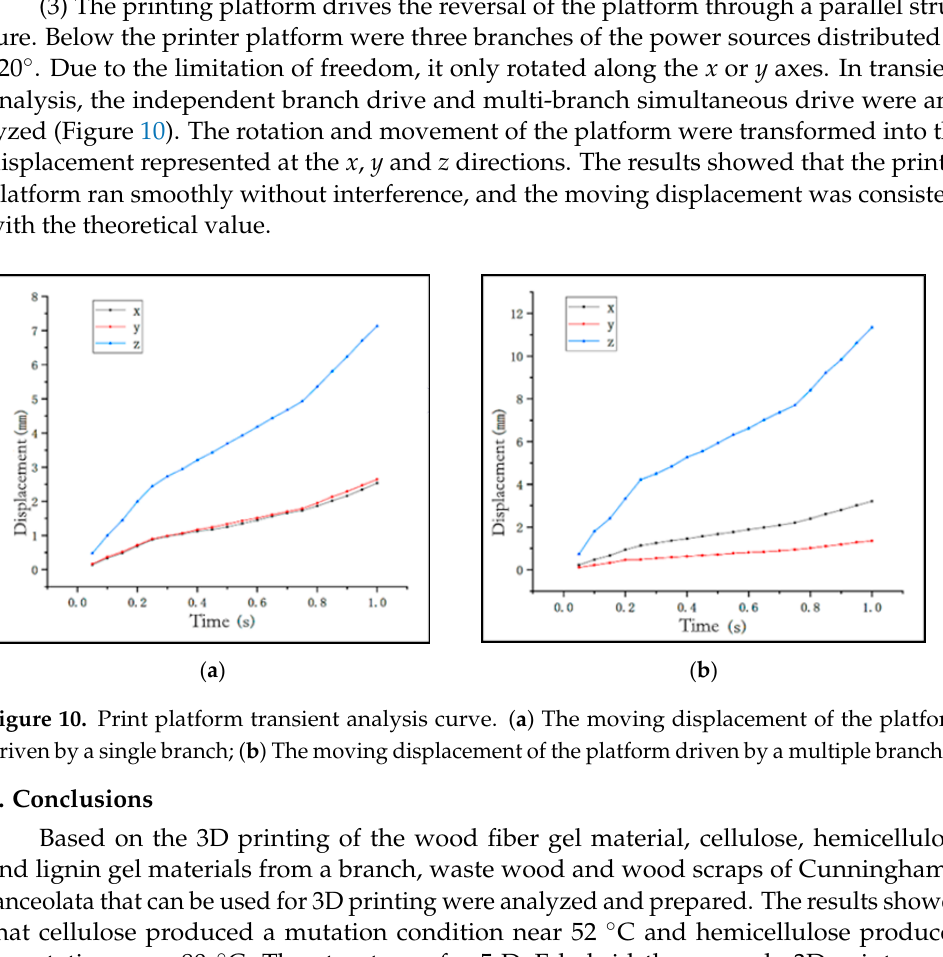
Figure 9. x -axis and y -axis linkage displacement curves. ( a ) the moving displacement of the x and y axis linked with the nozzle head; ( b ) the displacement of the z -axis.